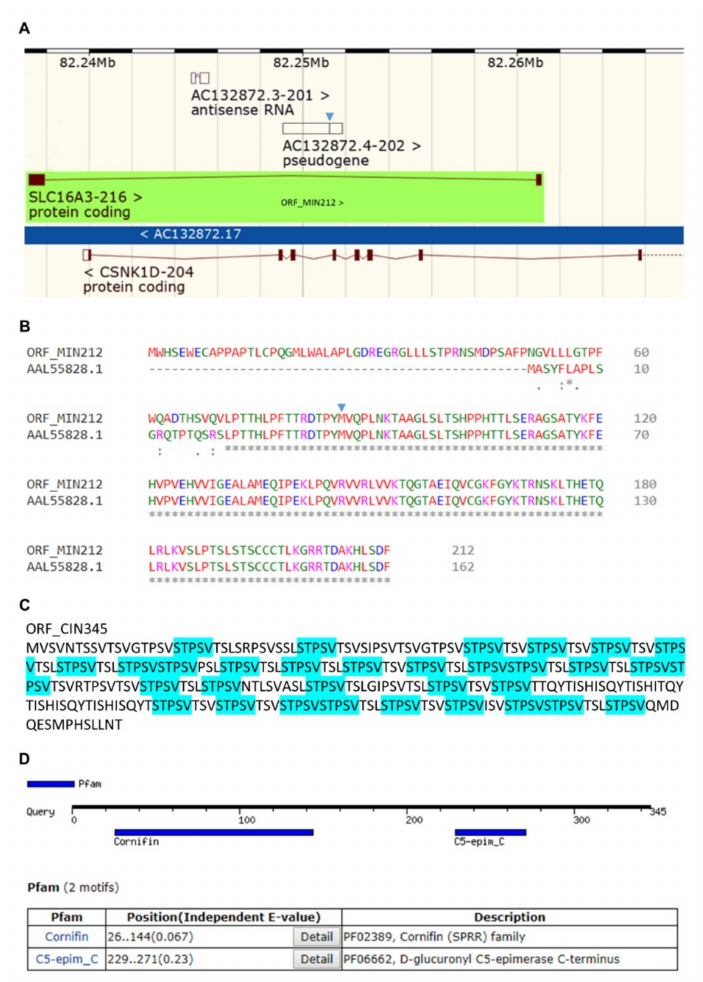
Figure 7. Identification of MCT4/SLC16A3-216 intron-derived novel proteins: sequence homologies and functional domains. ( A ) Graphical presentation of the MCT4/SLC16A3-216 splice-variant genomic area (modified from https://www.ensembl.org/Homo_sapiens/Gene/Summary?db=core; g=ENSG00000141526;r=17:82228397-82261129). Boxes denote the exons, while lines represent their in between introns. Note the DNA sequence overlap among MCT4/SLC16A3-216 (splice variant), AC132872.4-202 (pseudogene), and HCKID/CSNK1D-204 (splice variant) gene territories. “>”: forward strand transcription, “<”: reverse strand transcription, arrowhead: pseudogene intron (“intron-in-an-intron”). Due to its large size, the CSNK1D-204 transcript cannot be topologically aligned to the SLC16A3-216 (and the AC132872.4-202 pseudogene) one. ( B ) Amino acid sequence alignment of ORF_MIN212 to AAL55828.1 protein, via employment of Clustal Omega bioinformatics tool. The arrowhead indicates the amino terminal end of the second exon ORF that belongs to the AC132872.4-202 pseudogene. Note that retention of the intron ( A ) expands ORF length and its similarity to AAL55828.1 further upstream towards its amino terminal direction. ( C ) Amino acid sequence of the ORF_CIN345 protein, as revealed by engagement of the ORF Finder bioinformatics platform. Fonts with blue shading indicate the “STPSV” repeats. ( D ) Detection of functional domains, in the form